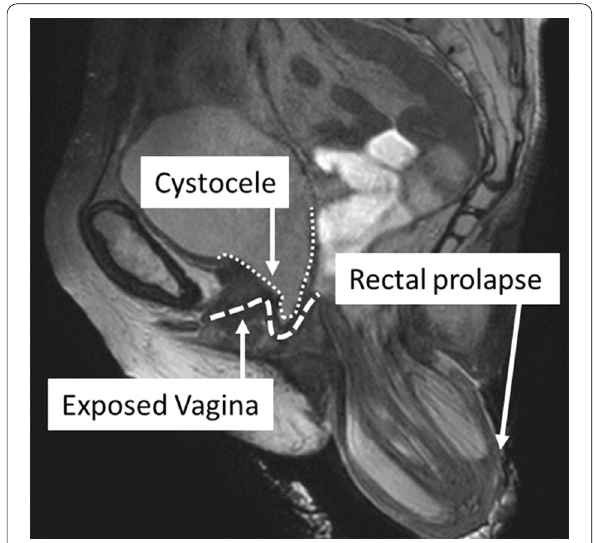
Fig. 2 The magnetic resonance Image (MRI) revealed the cystocele and the exposed vagina with rectal